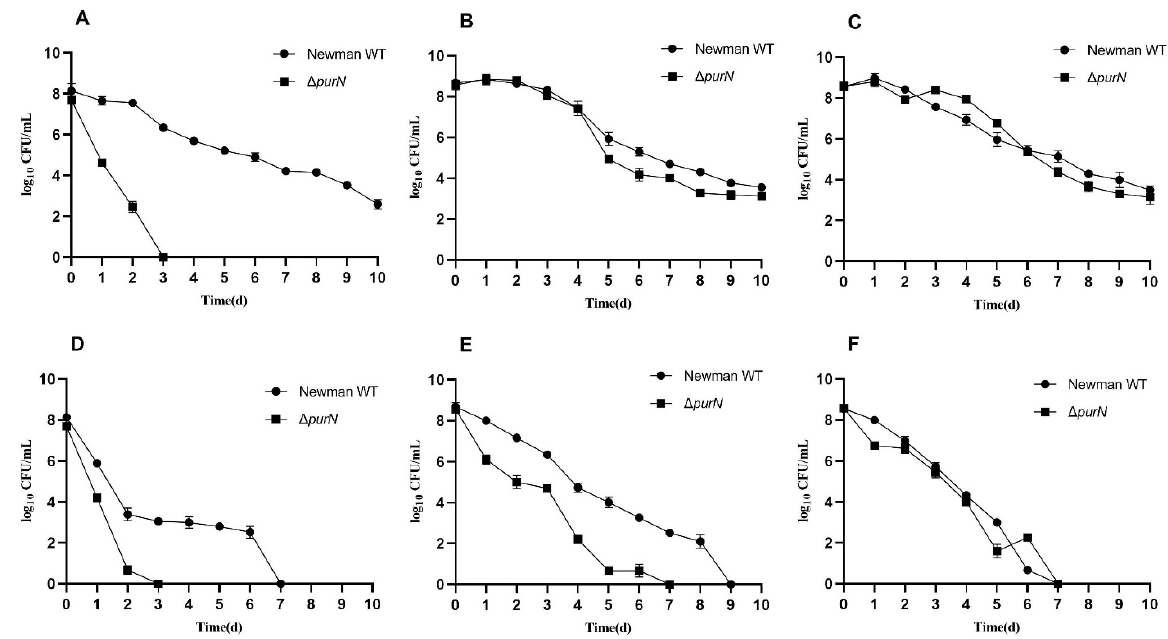
Figure 1. Exposure assay results of S. aureus wild-type, ∆ purN to ampicillin (10 µ g/mL, ( A – C )), and levofloxacin (20 µ g/mL, ( D – F )) in cultures at different time points. 5 h point ( A , D ). 9 h point ( B , E ). 18 h point ( C , F ).